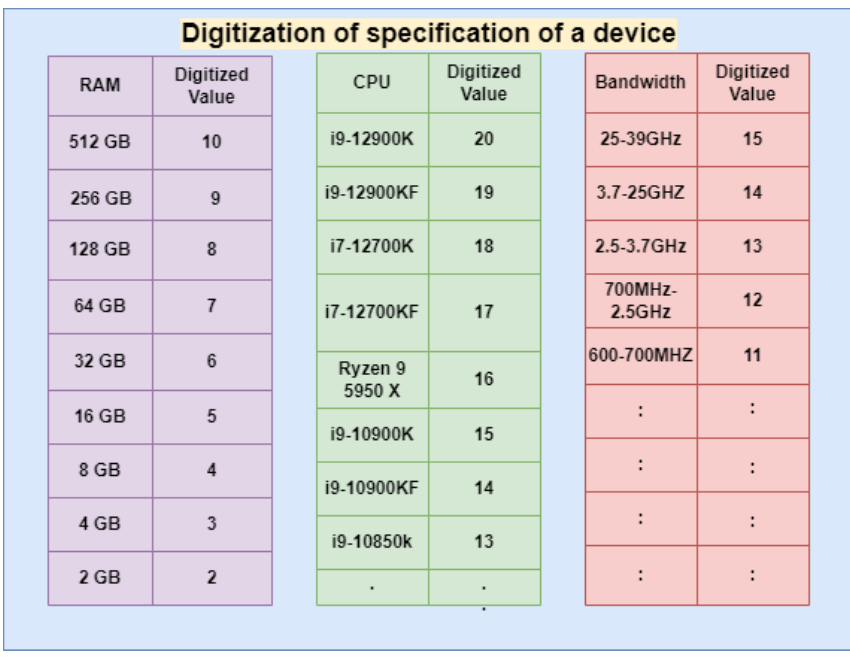
Figure 2. Random sample, digitization of specifications of various devices.